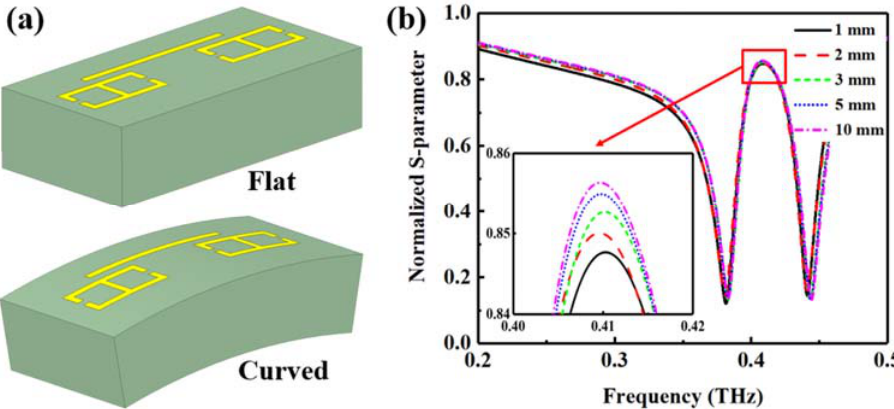
Figure 7. ( a ) Schematic of the flat and curved EIT MTM unit cells. ( b ) Simulated transmission spectra of the proposed EIT MTM unit cell with different curvature radius. The inset shows an enlarged view around the transmission peak.